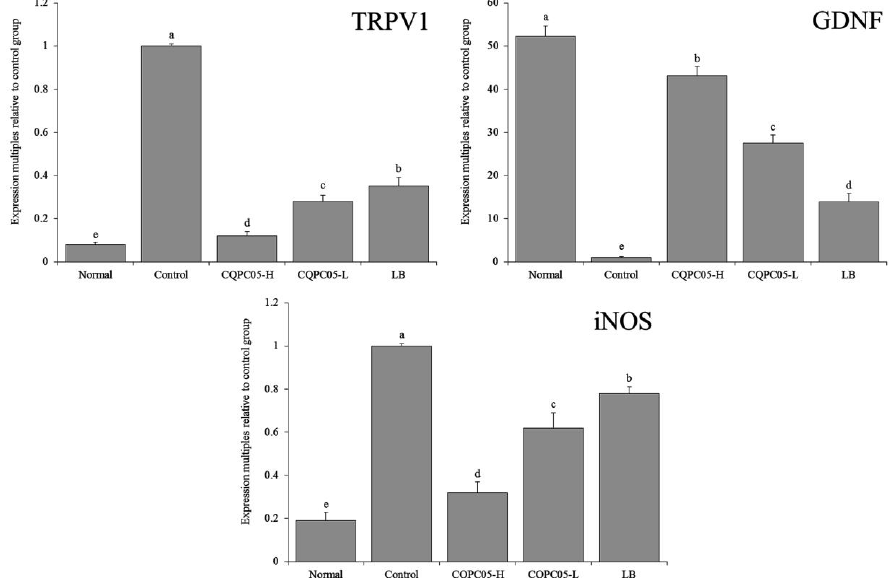
Figure 7. The small intestine tissue levels of mRNA expression of TRPV1, GDNF, and iNOS in the Lactobacillus plantarum CQPC05 and Lactobacillus delbrueckii subsp. bulgaricus treated activated carbon-induced constipation mice. a − e The different letters mean that there are significant differences ( p < 0.05) between every two groups according to Duncan’s multiple range test. LB: Lactobacillus delbrueckii subsp. bulgaricus (1.0 × 10 9 colony-forming unit (CFU)/kg body weight (bw)); CQPC05-L: Lactobacillus plantarum CQPC05 low dose (1.0 × 10 8 CFU/kg bw); CQPC05-H: Lactobacillus plantarum CQPC05 high dose (1.0 × 10 9 CFU/kg bw). GDNF: glial cell-derived neurotrophic factor; TRPV1: transient receptor potential cation channel subfamily V member 1; iNOS: inducible nitric oxide synthase.